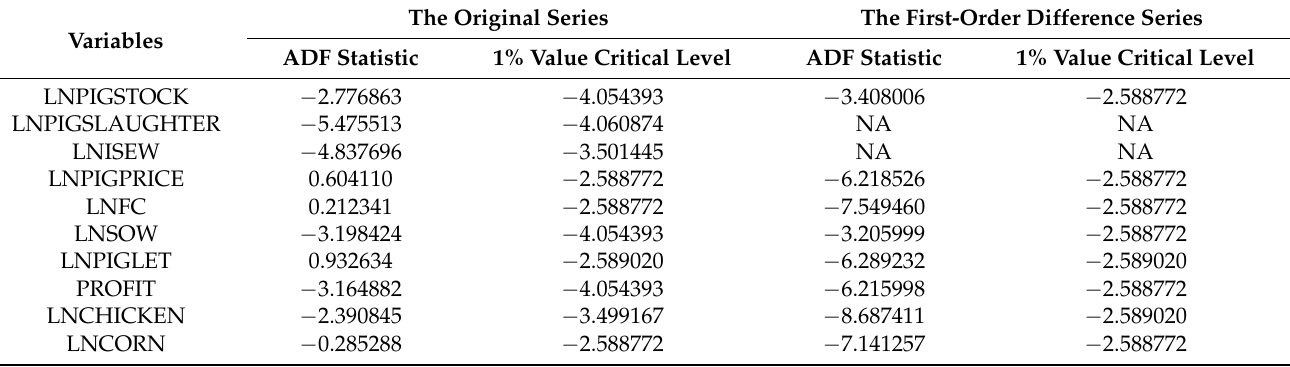
Table 2. The results of the stationary test (ADF